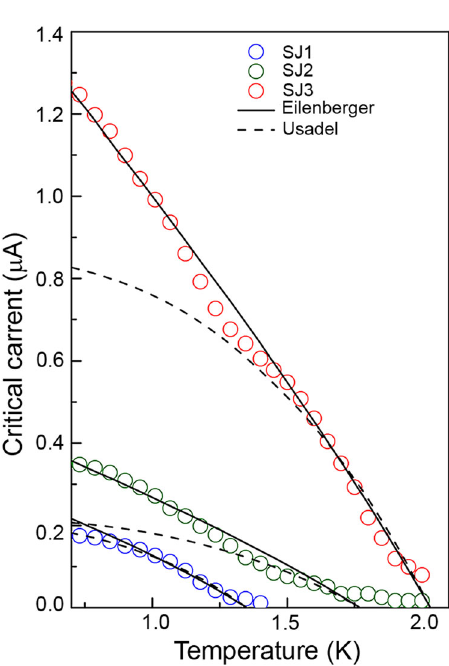
Fig. 3 Evolution of the critical current with temperature. Blue, green, and red open circles represent the experimental data points corresponding, respectively, to SJ1, SJ2, and SJ3 devices. The size of the circles corresponds to the measurement error. Black dashed lines: fi ts considering a diffusive transport (the KO-1 model). The curves fail in reproducing a steep rise of I c ( T ) at low temperatures. Black solid lines: fi ts within the ballistic regime (the KO-2